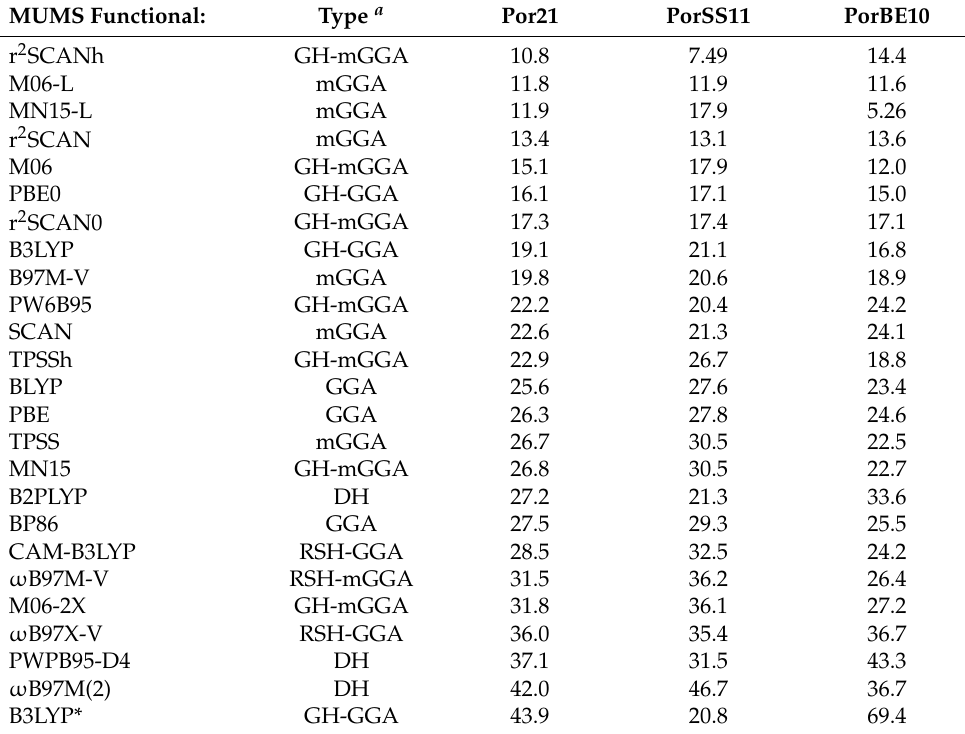
Table 2. General performance of selected functional approximations for the Por21 database for 25 of the “most used, most suggested” (MUMS) functionals in the literature. All values are mean unsigned errors (MUEs) in kcal/mol calculated from the CASPT2 reference